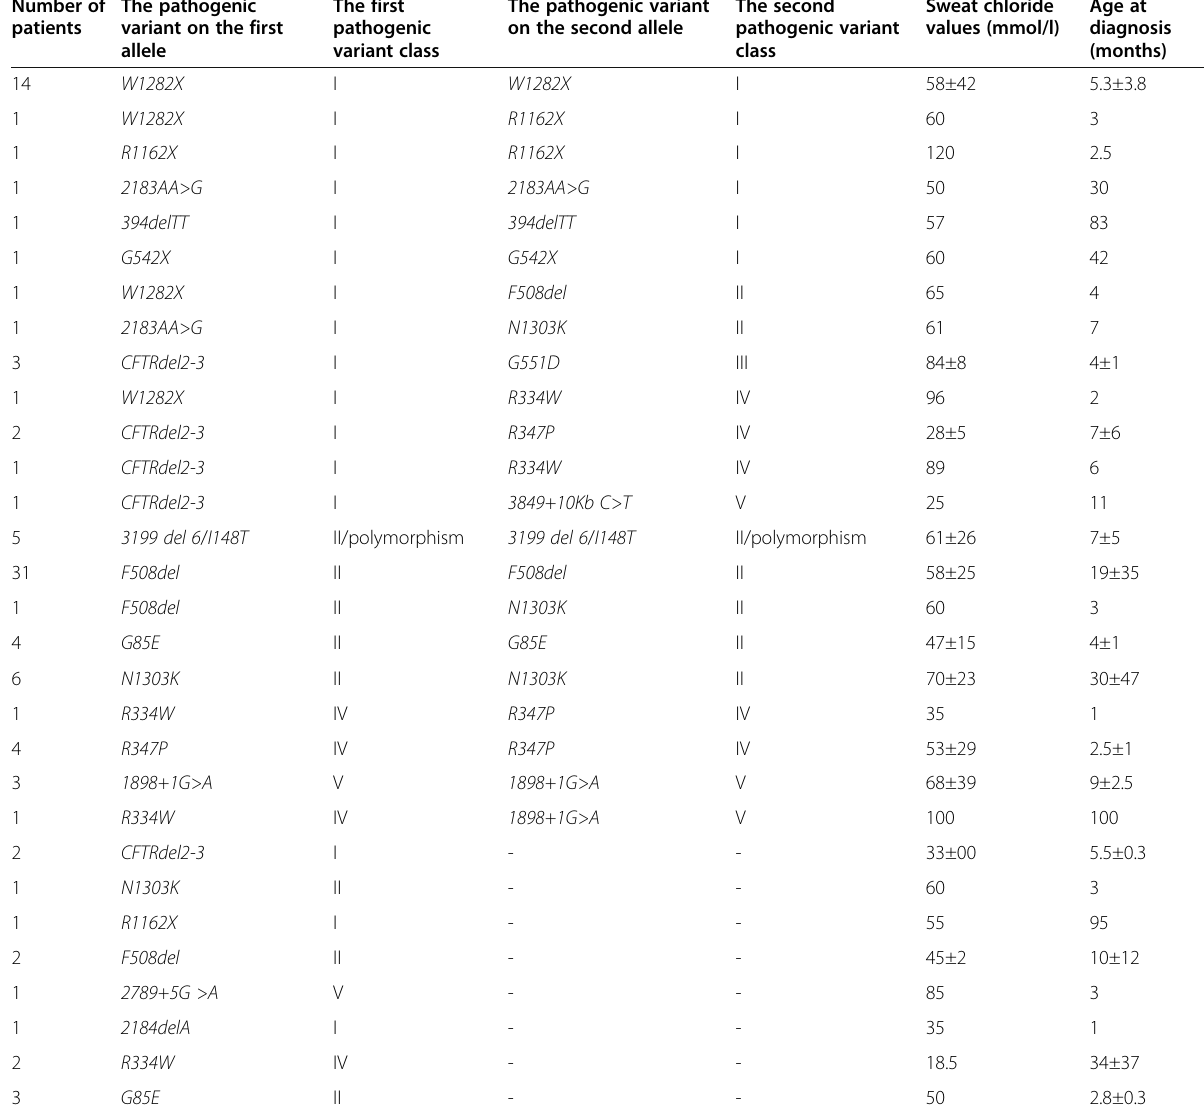
Table 4 CFTR pathogenic variants that were detected in the sample, its classifications, the result of sweat chloride test, and the age at